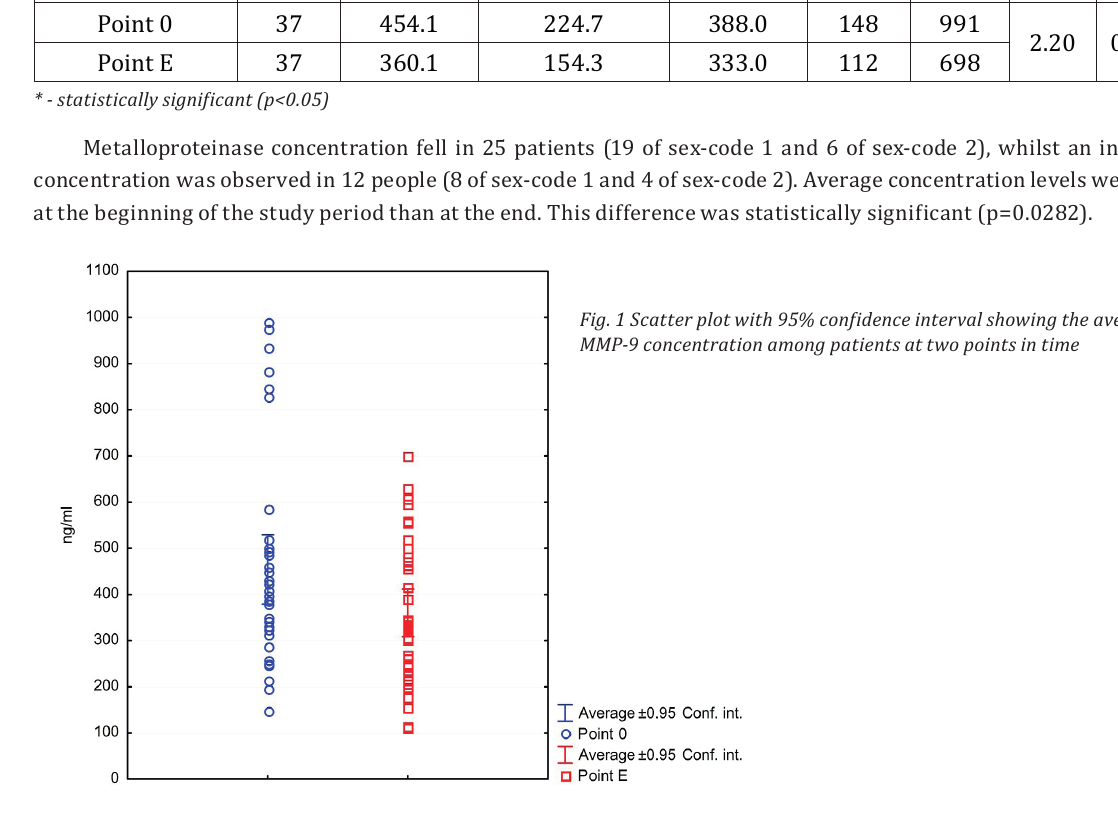
Table 3. Descriptive statistics – Concentration of MMP-9 among tested patients at two points in time and the results of the Wilcoxon Signed Rank test.